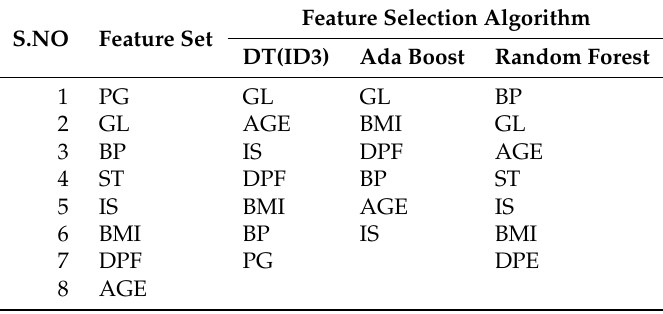
Table 4. Rank and score of features selected by DT (ID3), Ada Boost and Random Forest